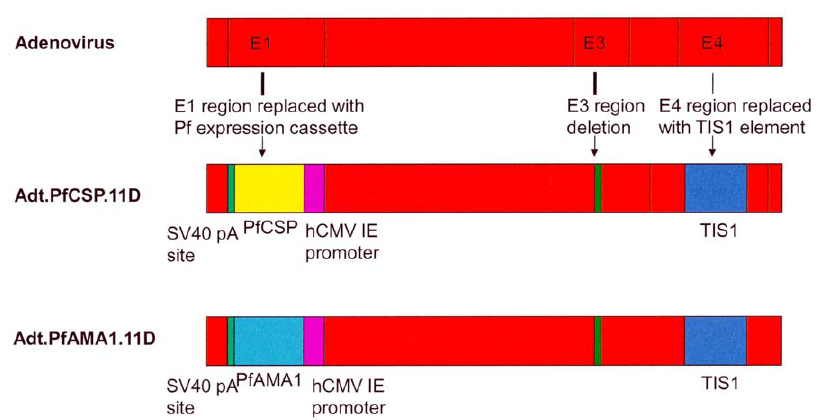
Figure 1. Schematic of Ad5-PfCSP and Ad5-PfAMA1 vectors. The parent adenovector was a serotype 5 adenovirus carrying deletions in E1, E4 and part of the E3 region with a transcriptionally inert spacer inserted into the site of the E4 deletion (TIS1), the resulting replication defective vector called GV11D. Codon-optimized CSP or AMA1 genes were inserted into the E1 region under the control of a cytomegalovirus promoter (hCMV IE). SV40 pA=simian virus 40 polyadenylation